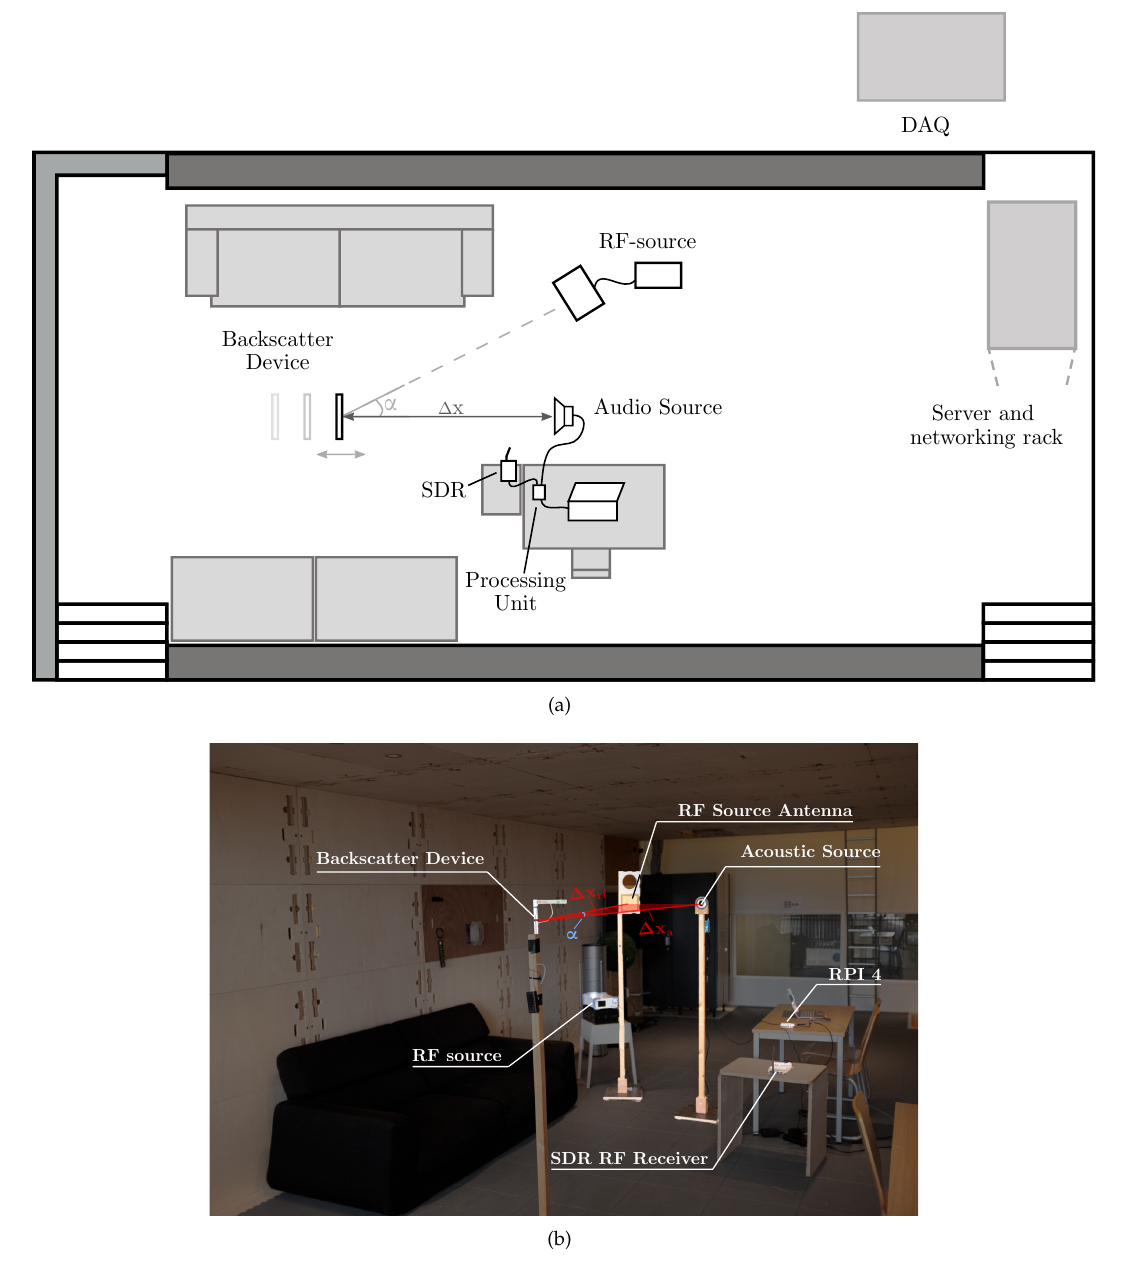
Figure 9. ( a ) Top view of the measurement setup in the Techtile environment; and ( b ) actual measure- ment